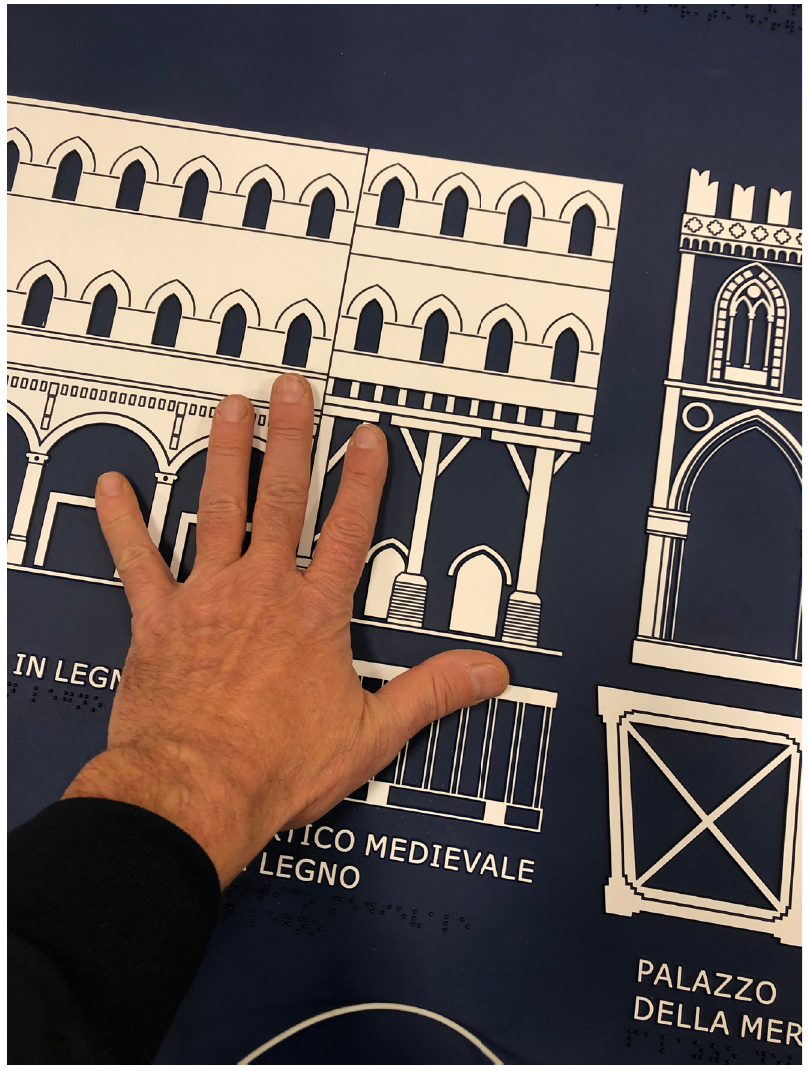
The monumental tactile map of the arcades for U-AREA FOR ALL - ROCK BOLOGNA